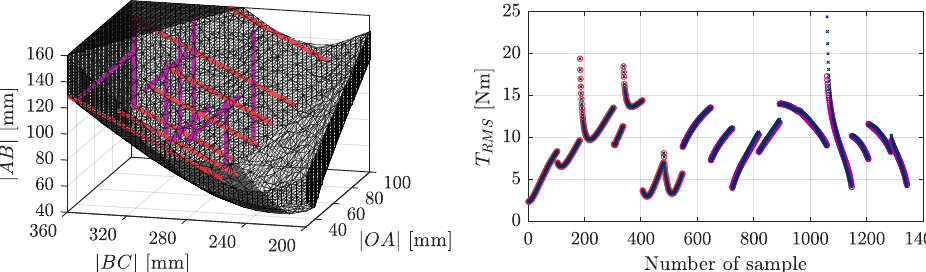
Figure 16. Validation directions at the left in purple and validation results of the blended model (17) at the